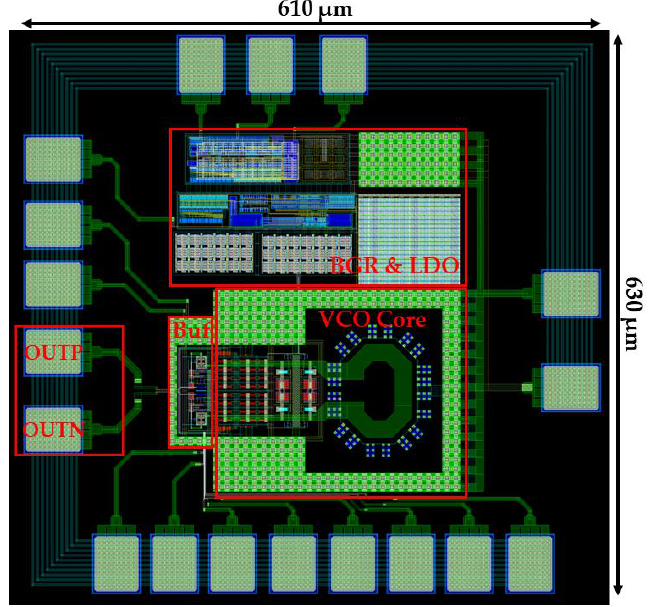
Figure 5. Layout of the proposed chip including a voltage-controlled oscillator and 50 Ω terminated output buffer.